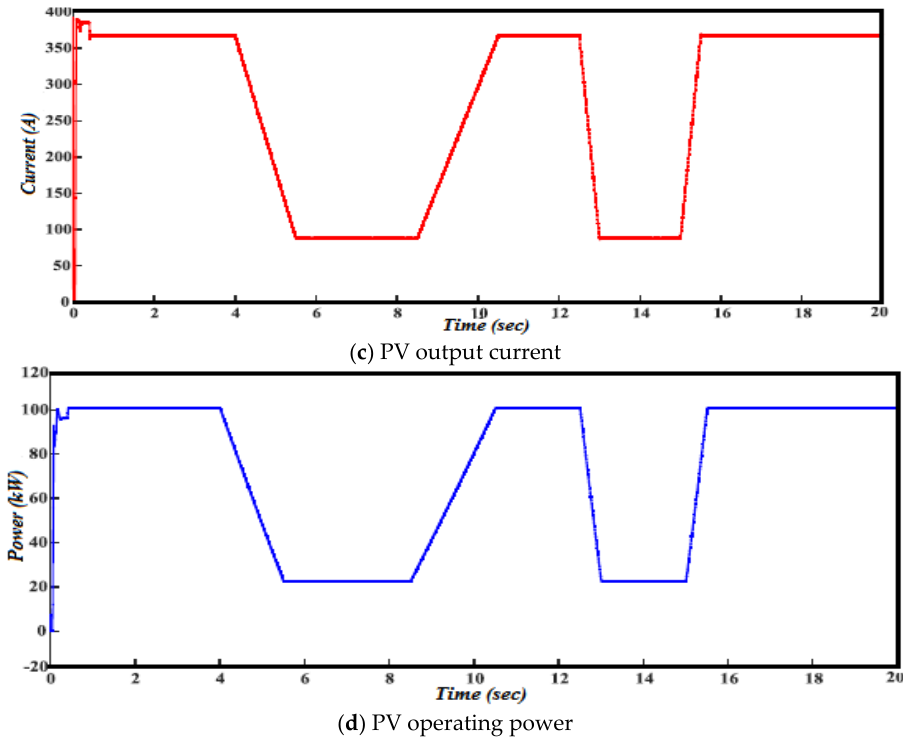
Figure 14. System performance of the PV array.